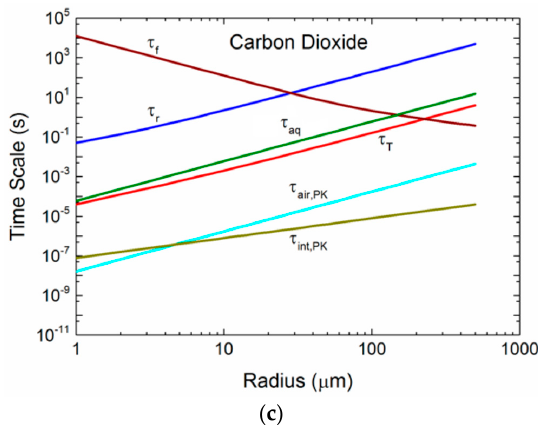
Figure 5. ( a ) For droplets of radius r 0 , the figure shows the microphysical time scales for temperature ( τ T ) and radius ( τ r ) evolution, the droplet residence time ( τ f ), and the time scales that govern transfer of helium molecules to or from a spray droplet in air ( τ air ), across the air-droplet interface ( τ int ), and within the droplet ( τ aq ). The interfacial time scale derives from both Pruppacher and Klett ([43]; τ int,PK ), Equation (2.11), and Seinfeld and Pandis ([38]; τ int,SP ), Equation (2.23). The time scale in air derives from Pruppacher and Klett ( τ air,PK ), Equation (2.10); and the aqueous mixing time scale ( τ aq ) is (2.25). Conditions here are for a 10-m wind speed of 12 m s − 1 , air temperature and water temperature of 20 °C, relative humidity of 85%, and sea surface salinity of 34 psu; the mass accommodation coefficient is set at α = 0.036. For this value, β 1 in Seinfeld and Pandis’s τ int,SP is π , and τ int,SP is the same as τ aq (from [3]); ( b ) for oxygen; ( c ) for carbon dioxide (from [3]). Figure 6 shows the range of τ air,PK values for our six gases. As with Figure 5a–c, τ air,PK increases monotonically with the molecular weight of the gas. In effect, the mean molecular speed predicted by the kinetic theory of gases decreases as the molecular weight increases (see (Equation (12)). Still, all our gases of interest can cross the jump layer well within the time granted by a droplet’s flight from creation and back to the sea surface. Note that τ f in Figure 6 is based on a wind speed of 12 m s − 1 ; at higher wind speeds, when spray concentrations would rapidly increase, τ f gets longer with the square of the wind speed.